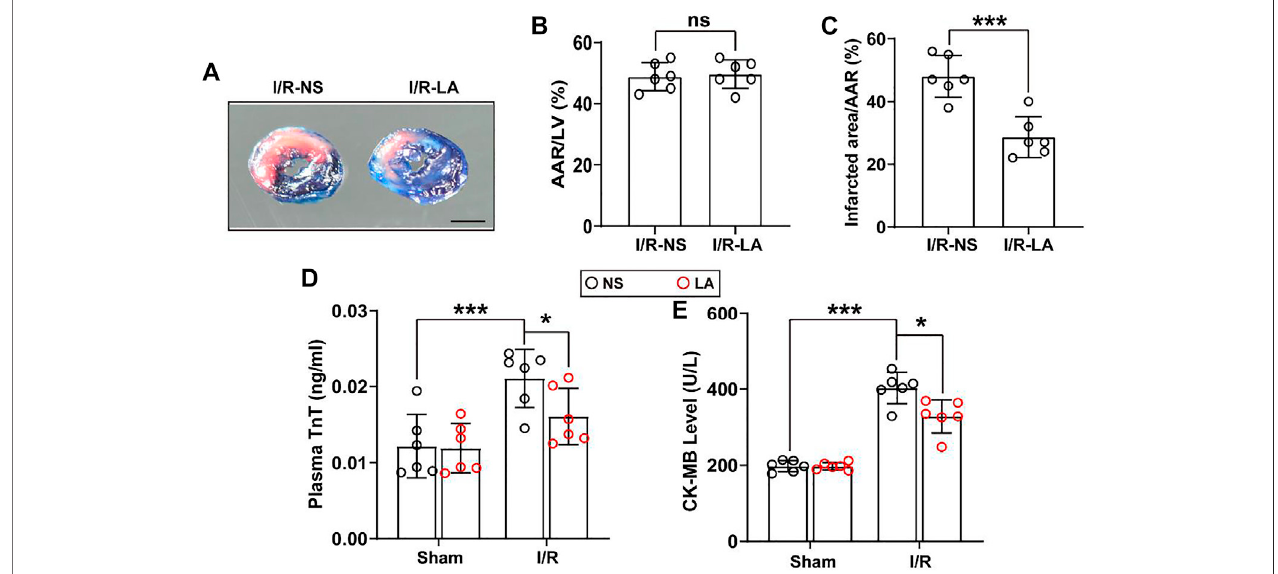
FIGURE1| LAameliorates MI/R-induced myocardialinjury (A) .Leftventricular (LV)tissue sectionsofboth LAandNSpretreated mice stainedwithEvans blueand 2,3,5-triphenyltetrazoliumchloride(TTC)at24 hafterMI/R,inordertodelineatetheareaatrisk(AAR)andtheinfarctedregion(Scalebar,1 mm) (B,C) .TheratiosofAAR/ LVandinfarctarea/AARwerecomparedbetweenLAandNSpretreatedmice( n (cid:1) 6) (D,E) .TheenzymeactivityofCK-MBandTnTinserumwereaccessedinLAandNS pretreatedmice24 hafterMI/RoperationbyElisaassay( n (cid:1) 6).Dataarepresentedasthemean ± SEM,witheachpointrepresentingamouse.*indicates p < 0.05, *** indicates p < 0.001, ns indicates no signi fi